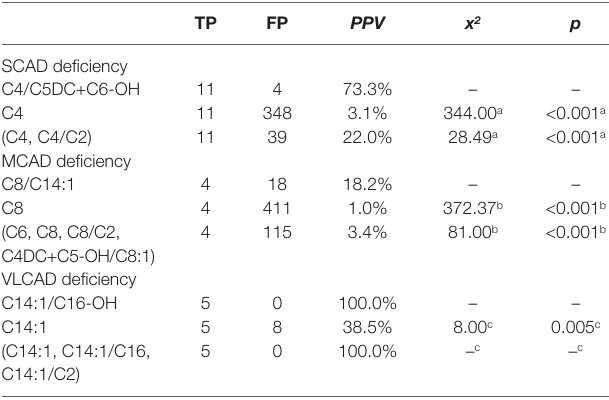
TABLE 4 | Comparison of optimal PPVs in the condition of 100% sensitivity for chain acyl-CoA dehydrogenase deficiencies between new ratio and used indicators using initial screening values in the testing